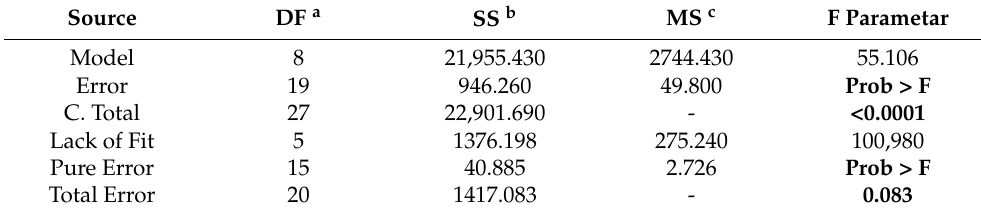
Table 5. ANOVA and Lack off fit